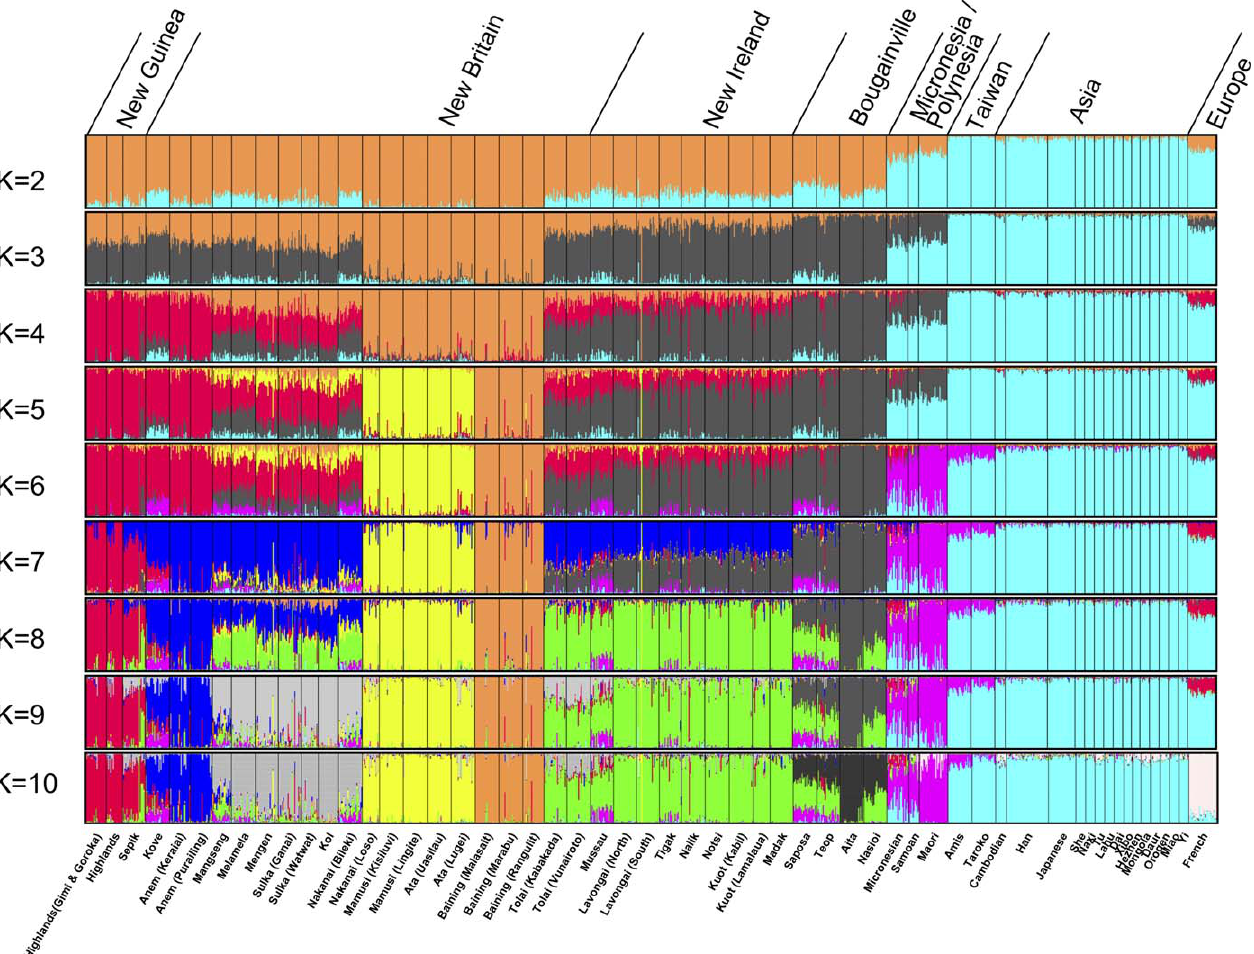
Figure 6. Pacific Population